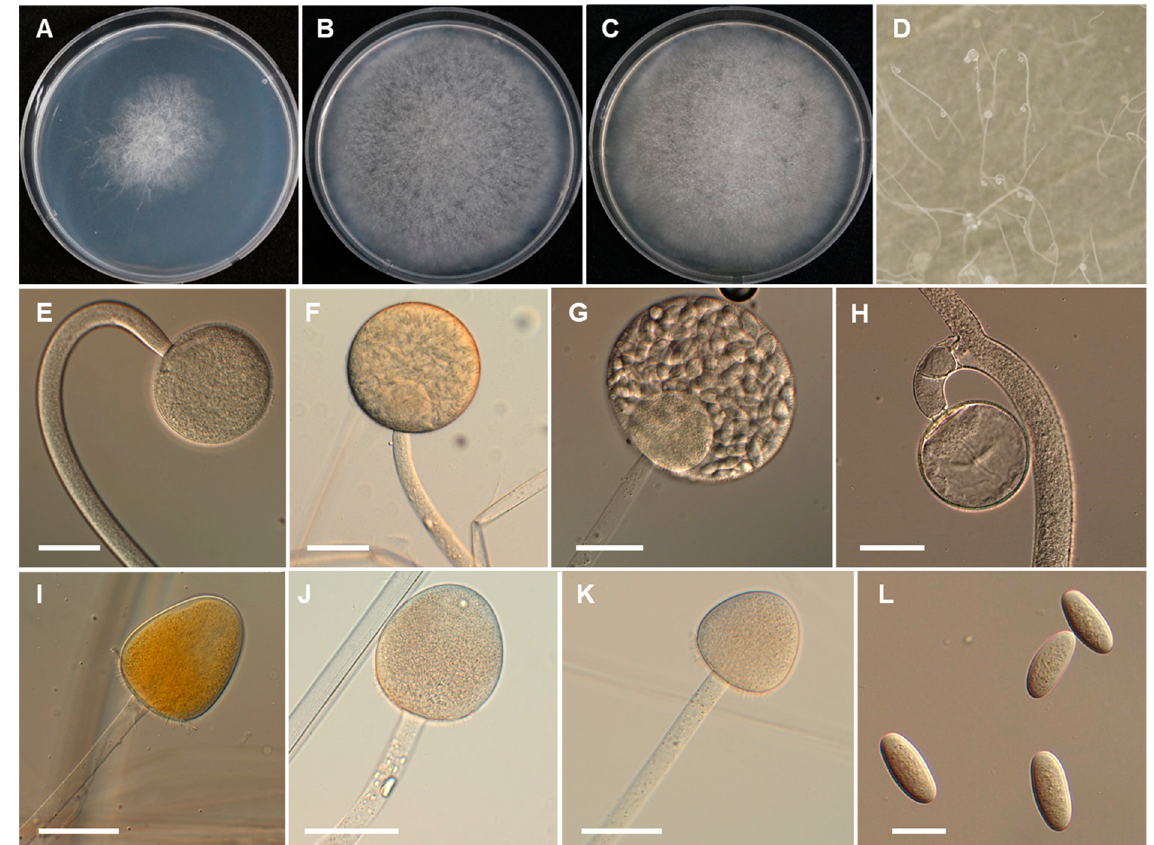
Figure 6. Morphology of Backusella oblongielliptica . A , Colony on SMA. B , Colony on PDA. C , Colony on MEA. D , Sporan- gium on circinate branches. E–G , Young and mature sporangia. H , Sterile sporangium. I–K , Columellae of different shapes. L , Sporangiospores. Scale bars: E–K = 50 μ m, L = 20 μ m.